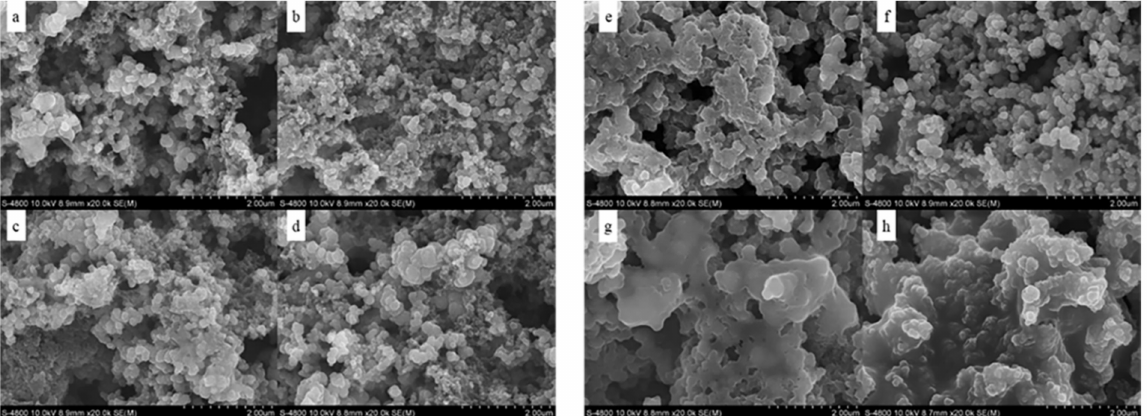
Figure 2. Surface morphology of HPEI-CPEG-pH6 anode ( a ), HPEI-CPEG-pH7 anode ( b ), HPEI- CPEG-pH8 anode ( c ), and HPEI-CPEG-pH10 anode ( d ). Surface morphology of HPEI-CPEG-pH6 anode ( e ), HPEI-CPEG-pH7 anode ( f ), HPEI-CPEG-pH8 anode ( g ), and HPEI-CPEG-pH10 anode ( h ) after 100